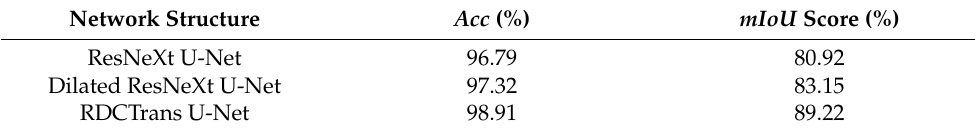
Table 3. Results of the ablation study of the proposed model RDCTrans